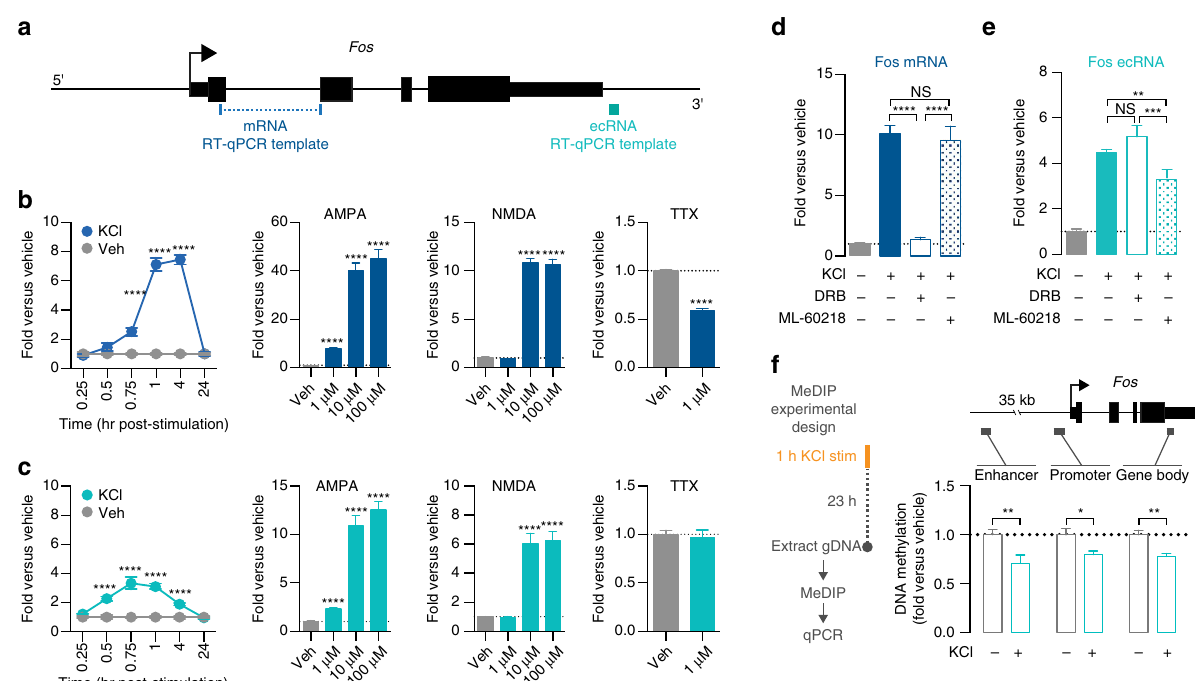
Figure 4 | Fos ecRNA is differentially responsive to neuronal activation and undergoes unique biogenesis. ( a ) RT-qPCR template locations used to distinguish between Fos mRNA and ecRNA. ( b ) Modulation of Fos mRNA by KCl, AMPA, NMDA and TTX reveals overall timecourse and activity- dependence of Fos gene transcription. Fos mRNA is upregulated as soon as 45min after KCl treatment, and peaks at 4h following stimulation. AMPA and NMDA treatment (1h) produced dose-dependent increases in Fos mRNA, whereas neuronal silencing with TTX decreased Fos mRNA. ( c ) In contrast, Fos ecRNA is induced within 30min of neuronal depolarization with KCl, and peaks at 45min following KCl treatment. Neuronal stimulation with KCl, AMPA and NMDA induced much lower levels of ecRNA transcription (as compared with mRNA), and neuronal inactivation with TTX did not alter Fos ecRNA transcription. ( n ¼ 3–6 per group for KCl experiments, 3 per group for AMPA and NMDA experiments, and 6 per group for TTX experiments). ( d , e ) 4-h pretreatment with the RNAPII-dependent transcription inhibitor 5, 6-dichloro-1-beta- D -ribofuranosylbenzimidazole (DRB) had no effect on Fos ecRNA but blocked mRNA induction after 1-hour KCl treatment, whereas pretreatment with the RNAPIII inhibitor ML-60218 had no effect on Fos mRNA but decreased ecRNA induction after KCl treatment ( n ¼ 6–12 per group; mRNA one-way ANOVA, F (3,32) ¼ 78.86, P o 0.0001; ecRNA one-way ANOVA, F (3,32) ¼ 66.55, P o 0.0001; Tukey’s post hoc test for individual comparisons). ( f ) Left, MeDIP experimental design. Right, DNA methylation decreases 24h after KCl treatment in the enhancer, promoter and gene body of the Fos locus ( n ¼ 8, unpaired Student’s t -test; t 16 4 2.733 and P o 0.015 for each comparison). All data are expressed as mean ± s.e.m. Individual comparisons, * P o 0.05, ** P o 0.01, *** P o 0.001 and **** P o